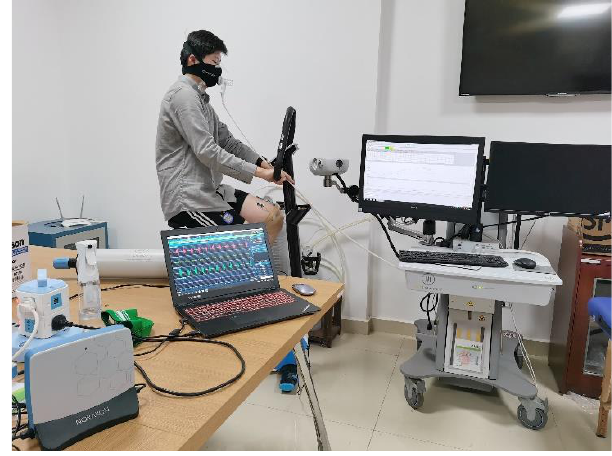
Figure 2. Representative participant performs exercise test.